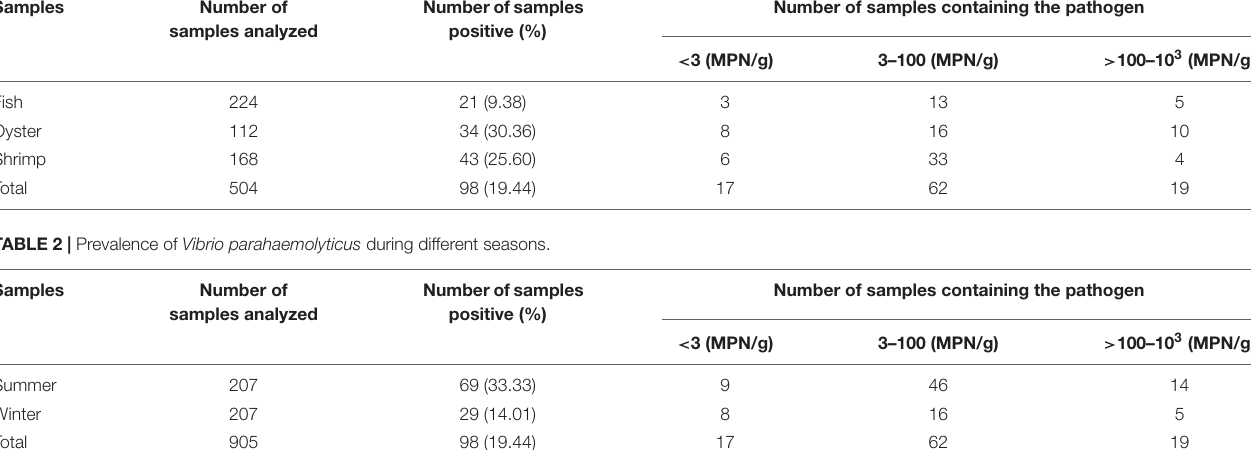
TABLE 1 | Prevalence of Vibrio parahaemolyticus in food samples from South China. Samples Number of samples analyzed